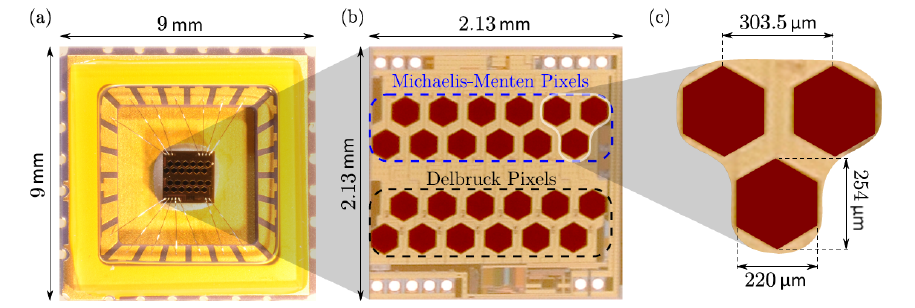
Figure 1. ( a ) The M 2 APix sensor chip with its wire bounding; ( b ) the silicon retina composed of 12 Michaelis–Menten pixels and 12 additional Delbrück pixels; ( c ) view of three neighboring pixels. From